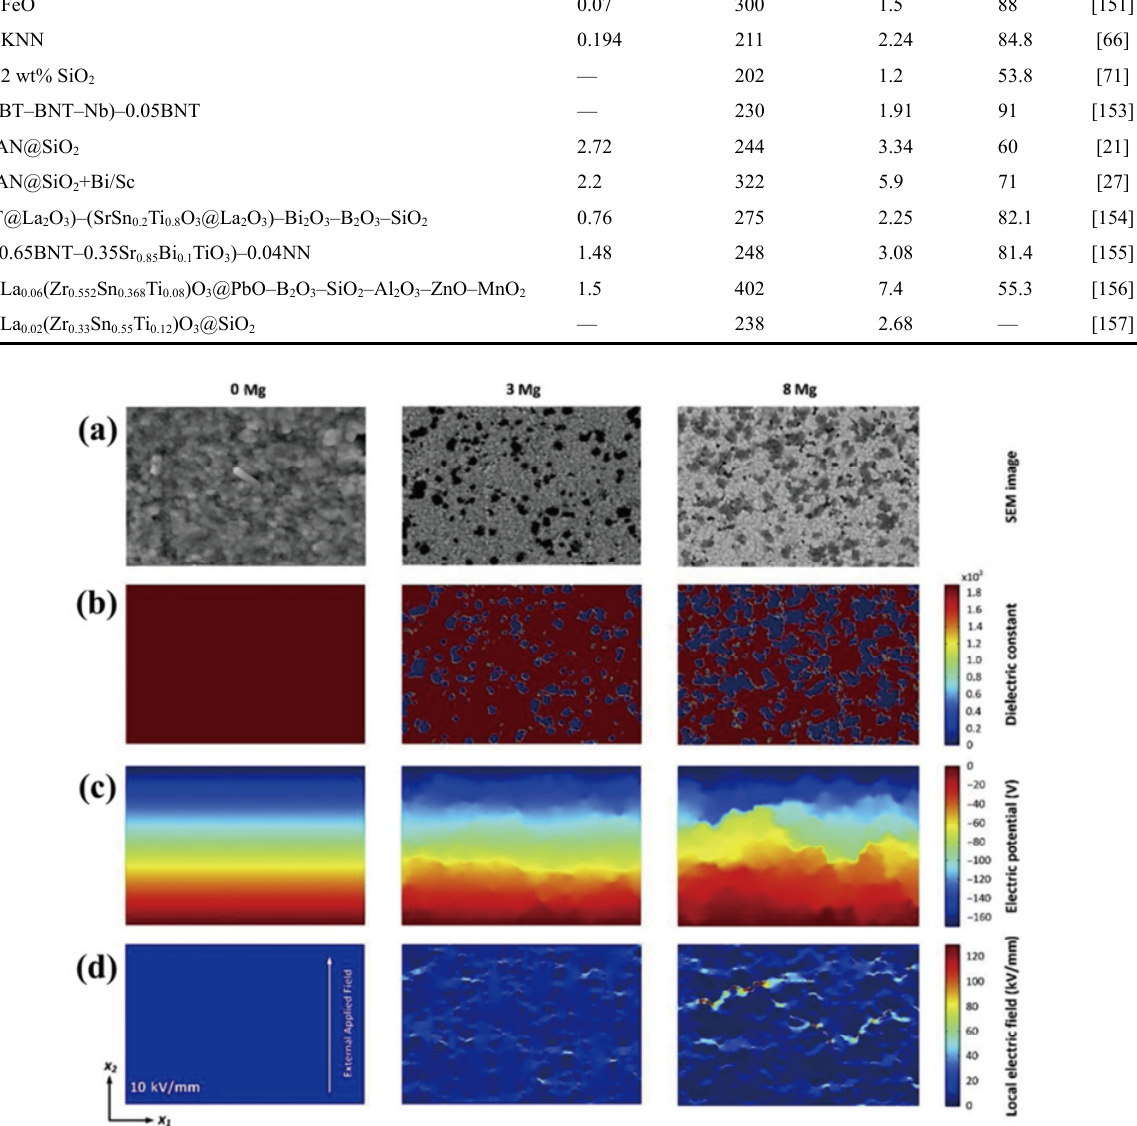
Fig. 15 (a) SEM images of BNST/MgO ceramics. (b) Dielectric constants, (c) electric potentials, and (d) local electric fields of BNST/MgO ceramics. Reproduced with permission from Ref. [69], © Elsevier Ltd.